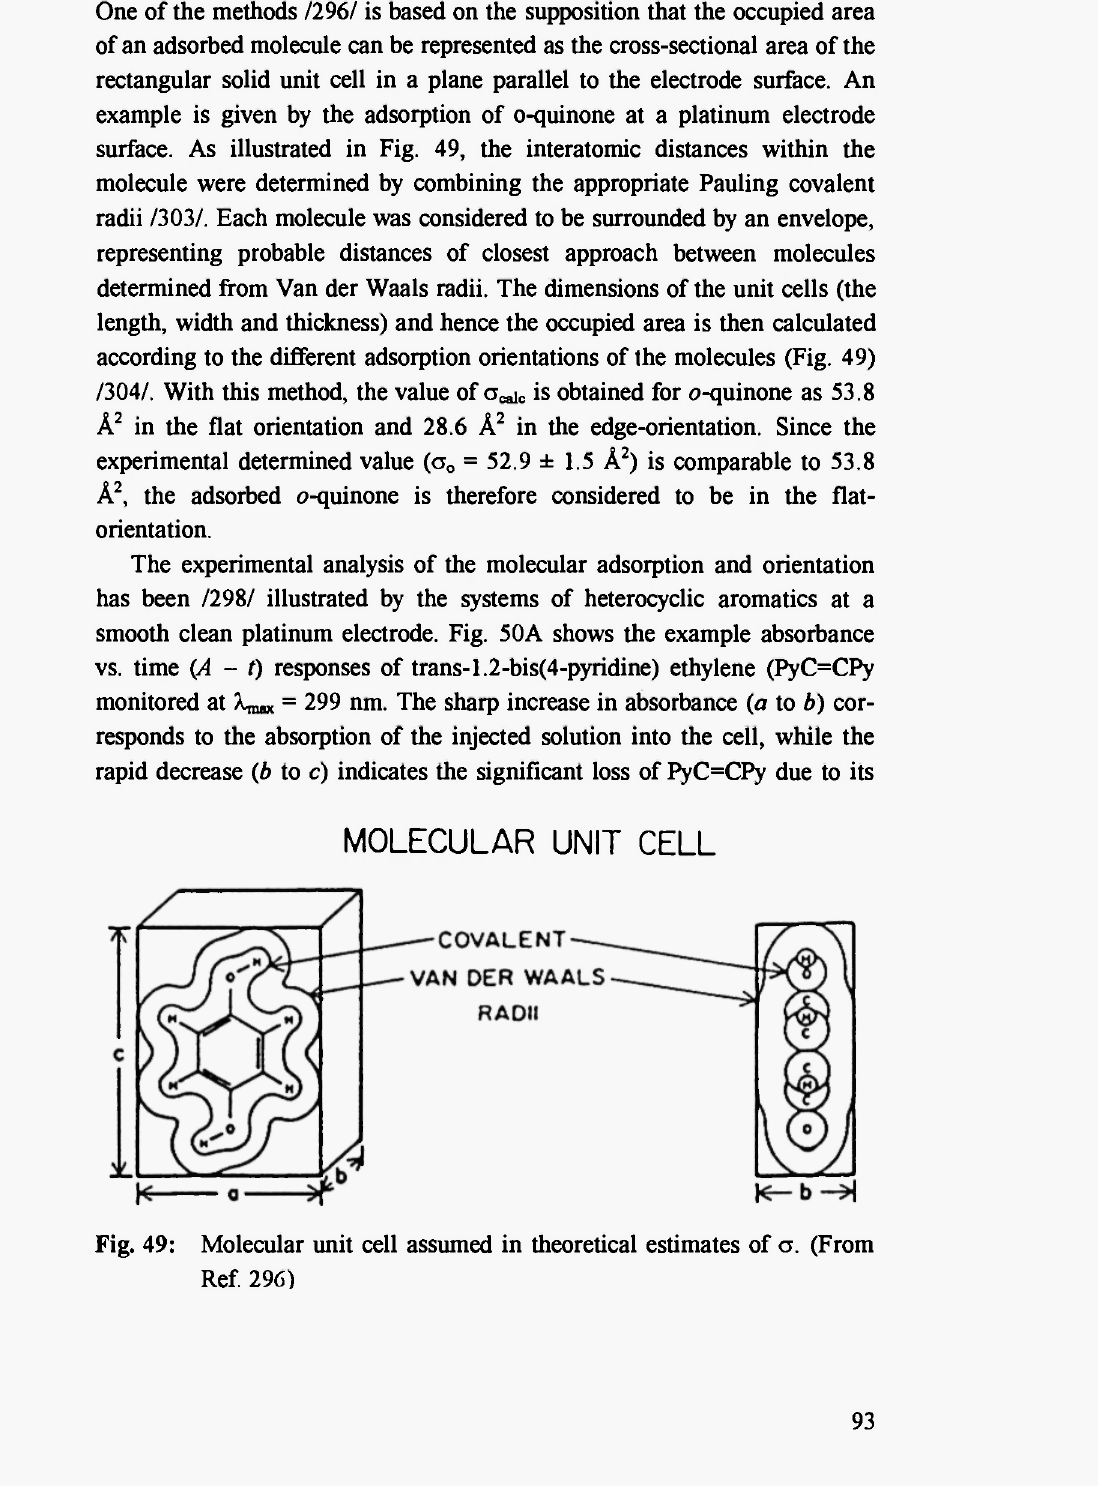
Fig. 49: Molecular unit cell assumed in theoretical estimates of σ. (From Ref.